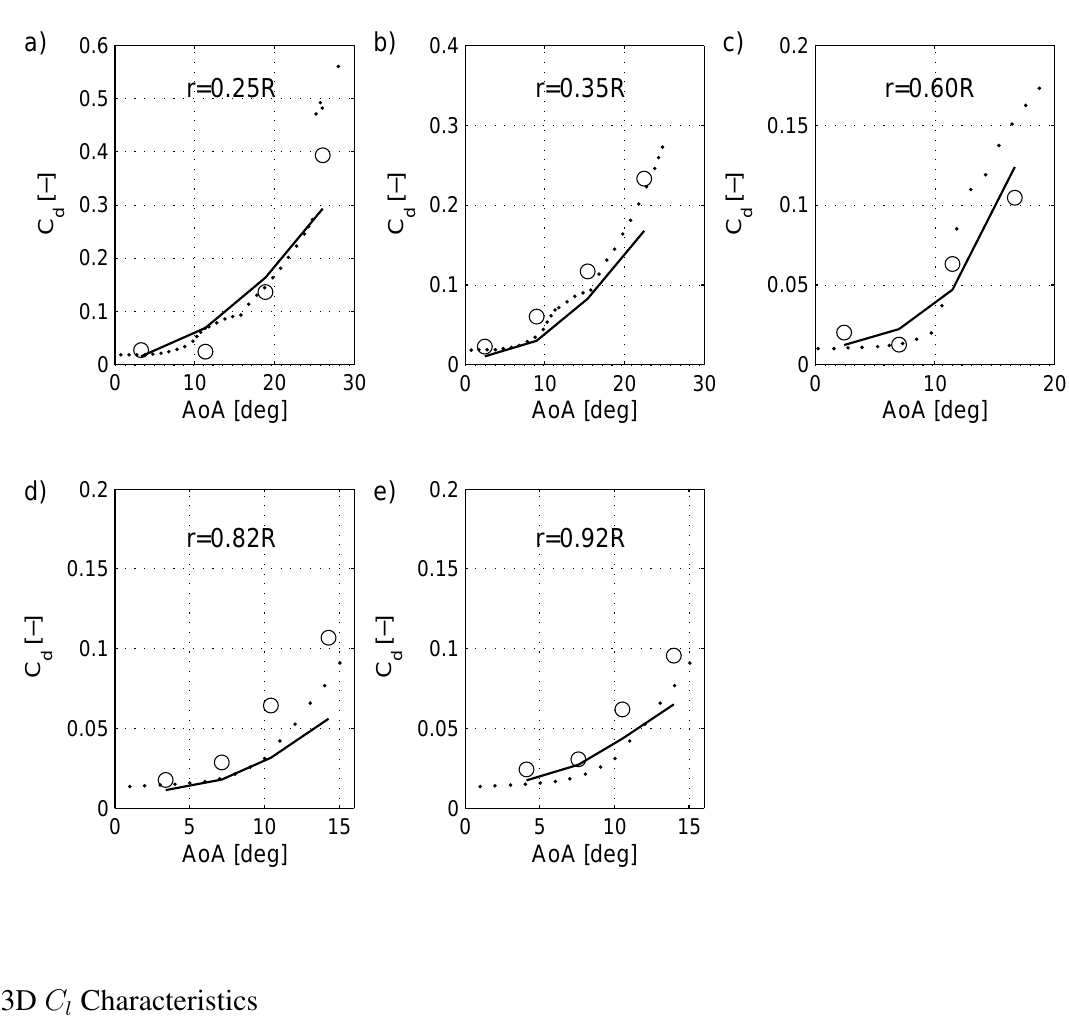
Figure 2. Comparison of C characteristics at five different spanwise positions d corresponding to ( a ) 0.25R, ( b ) 0.35R, ( c ) 0.60R, ( d ) 0.82R and ( e ) 0.92R. The dotted lines represent 2D experimental results; the circles indicate 3D experimental results and the full lines show 3D numerical